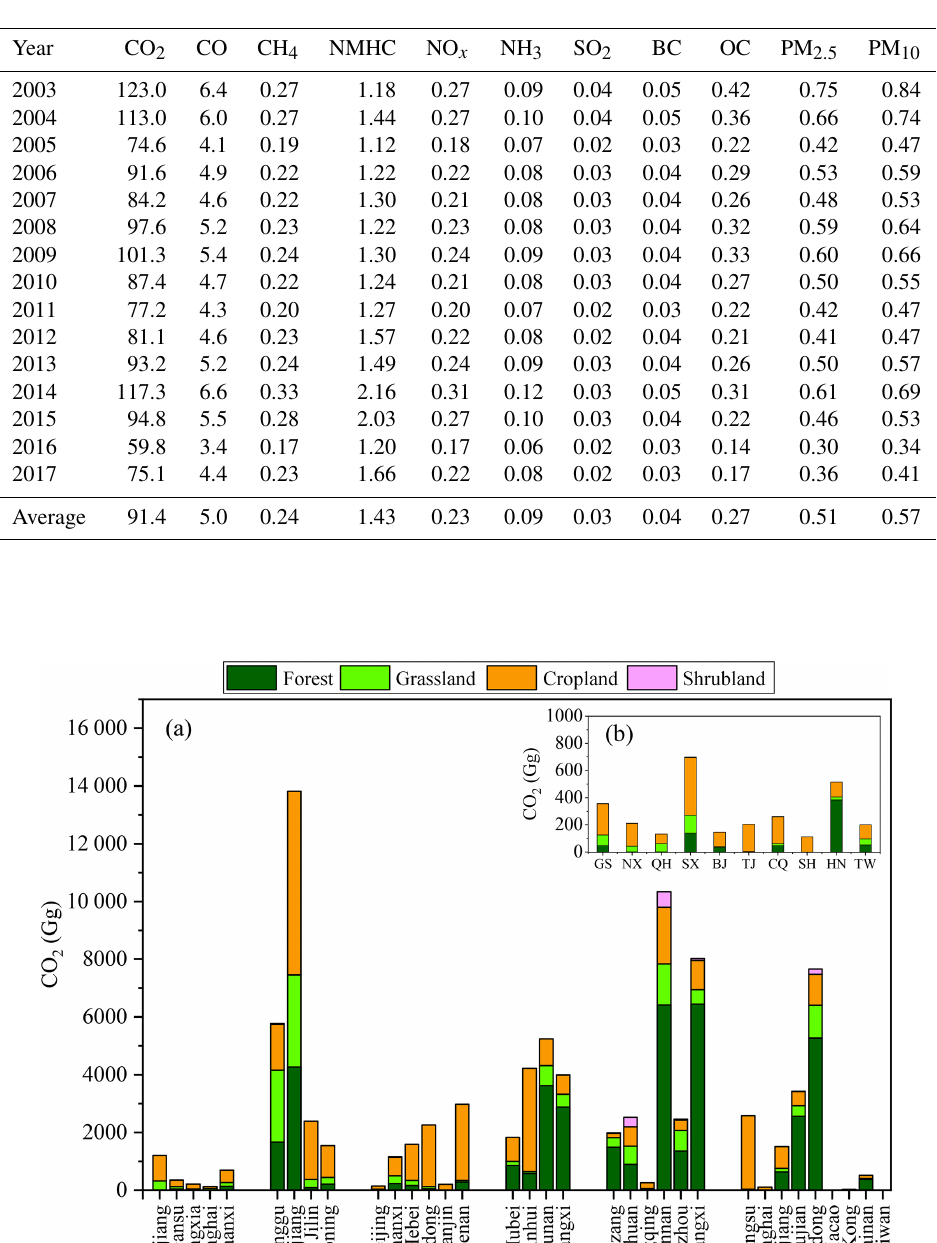
Table 1. Biomass burning emissions inventory (Tg) of China from 2003 to 2017.